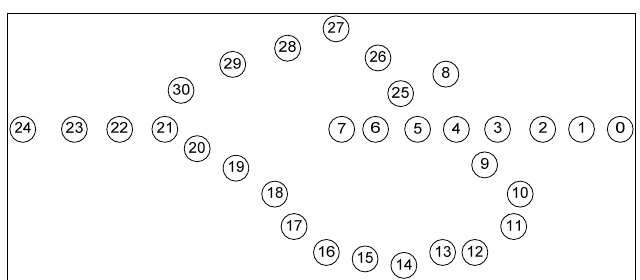
Figure 18. Closed void.